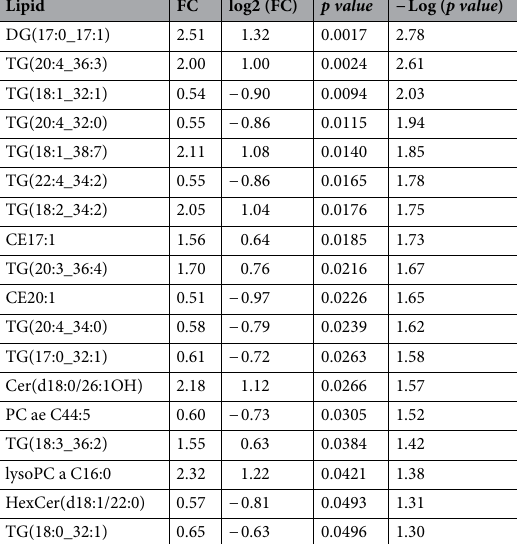
Table 2. Differentially abundant lipids in the severe condition versus medium